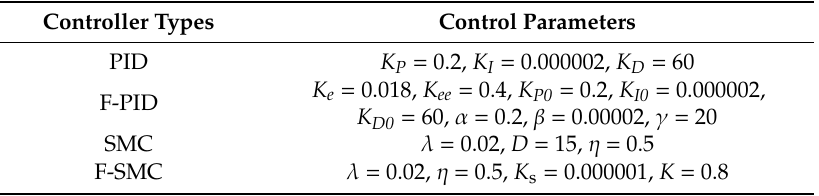
Table 6. Parameters of di ff erent